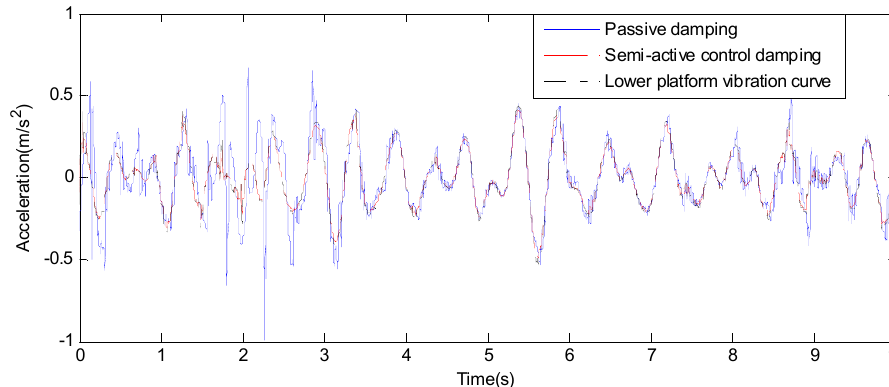
Figure 27. The y -axis direction simulation results.